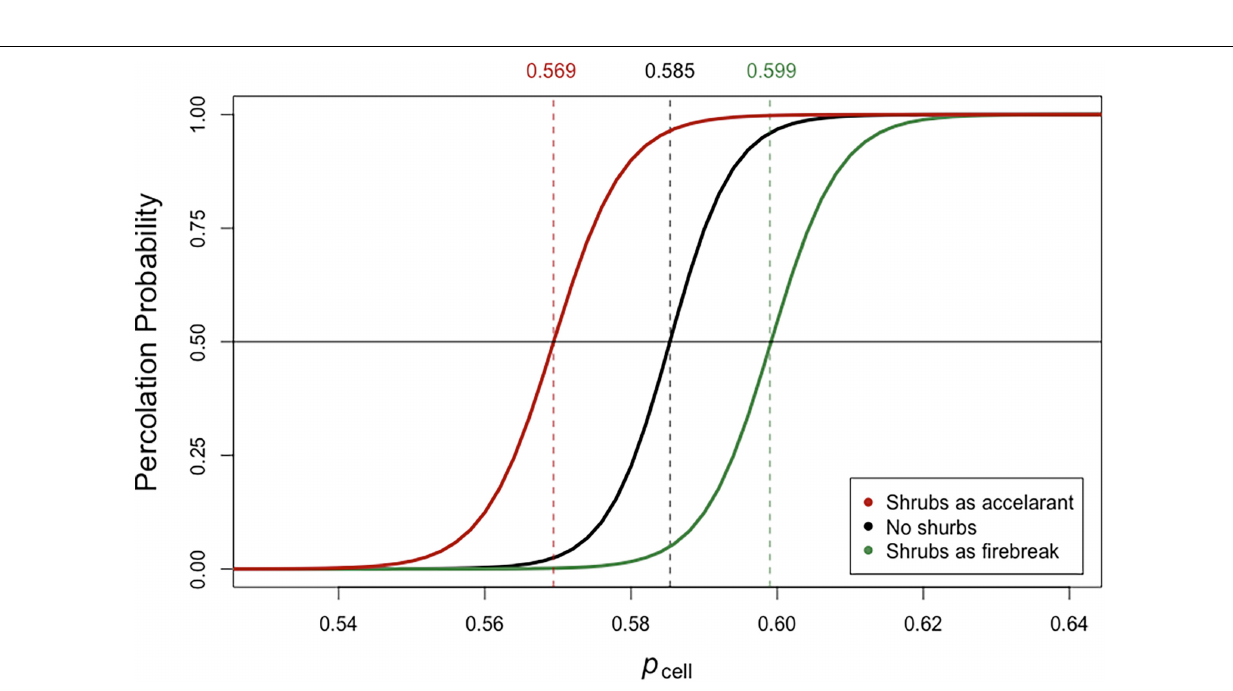
Frontiers in Ecology and Evolution |